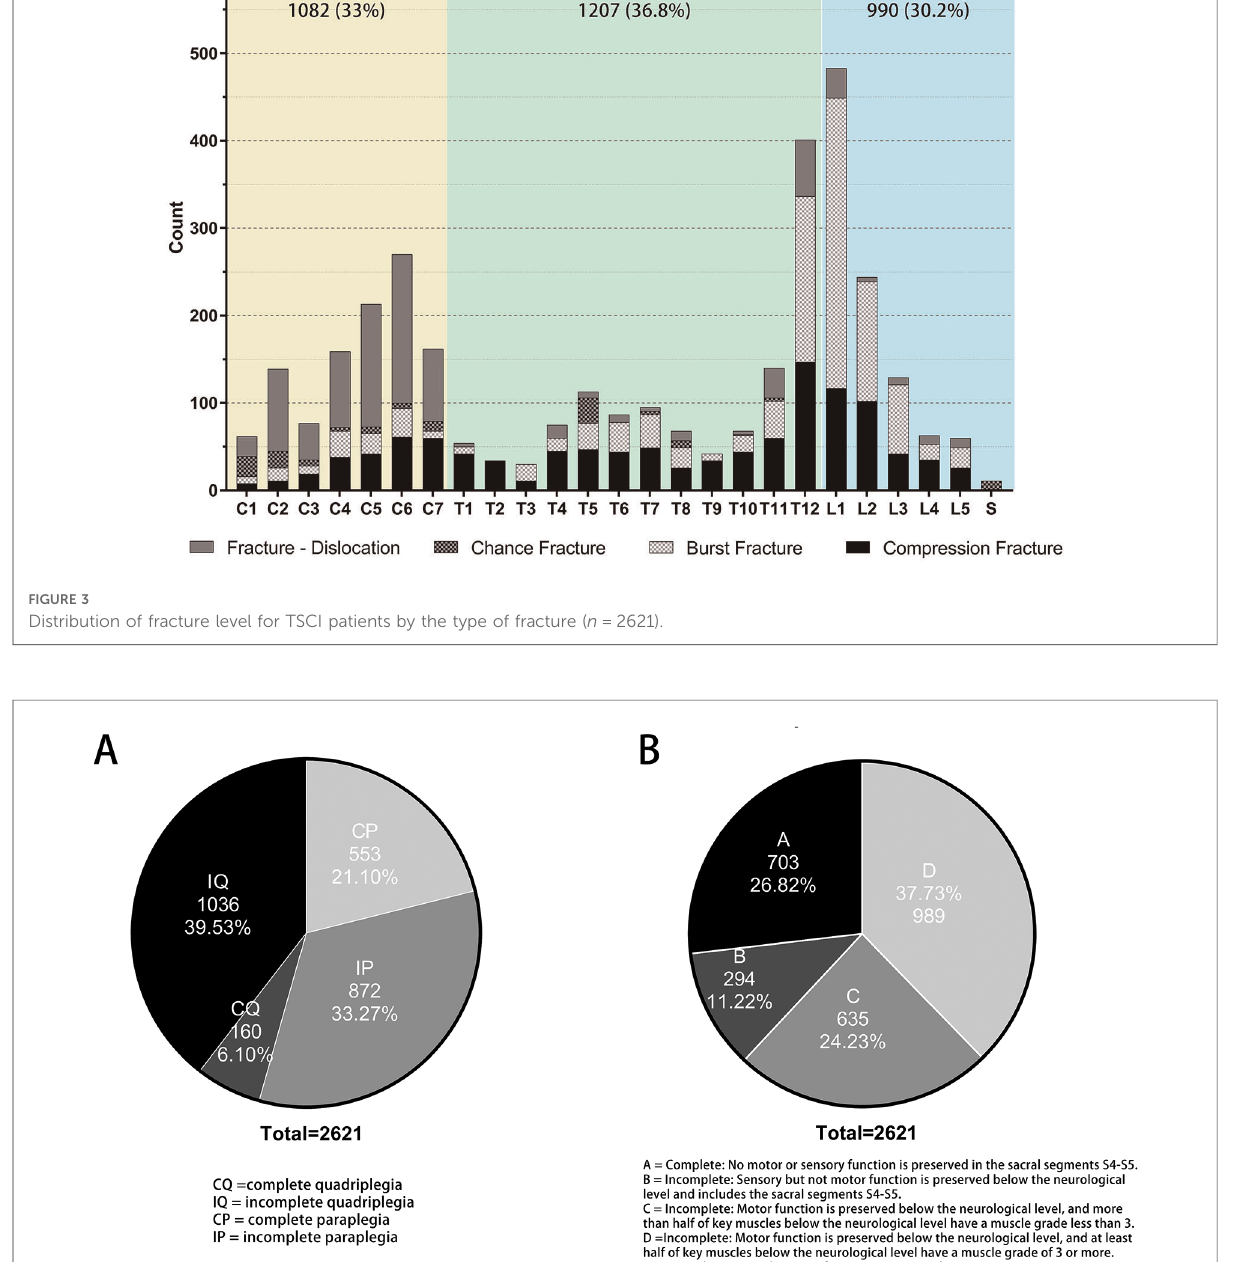
FIGURE 4 The severity of patients with TSCI: ( A ) The degree of injury; ( B ) Their spinal function after injury evaluated by ASIA impairment